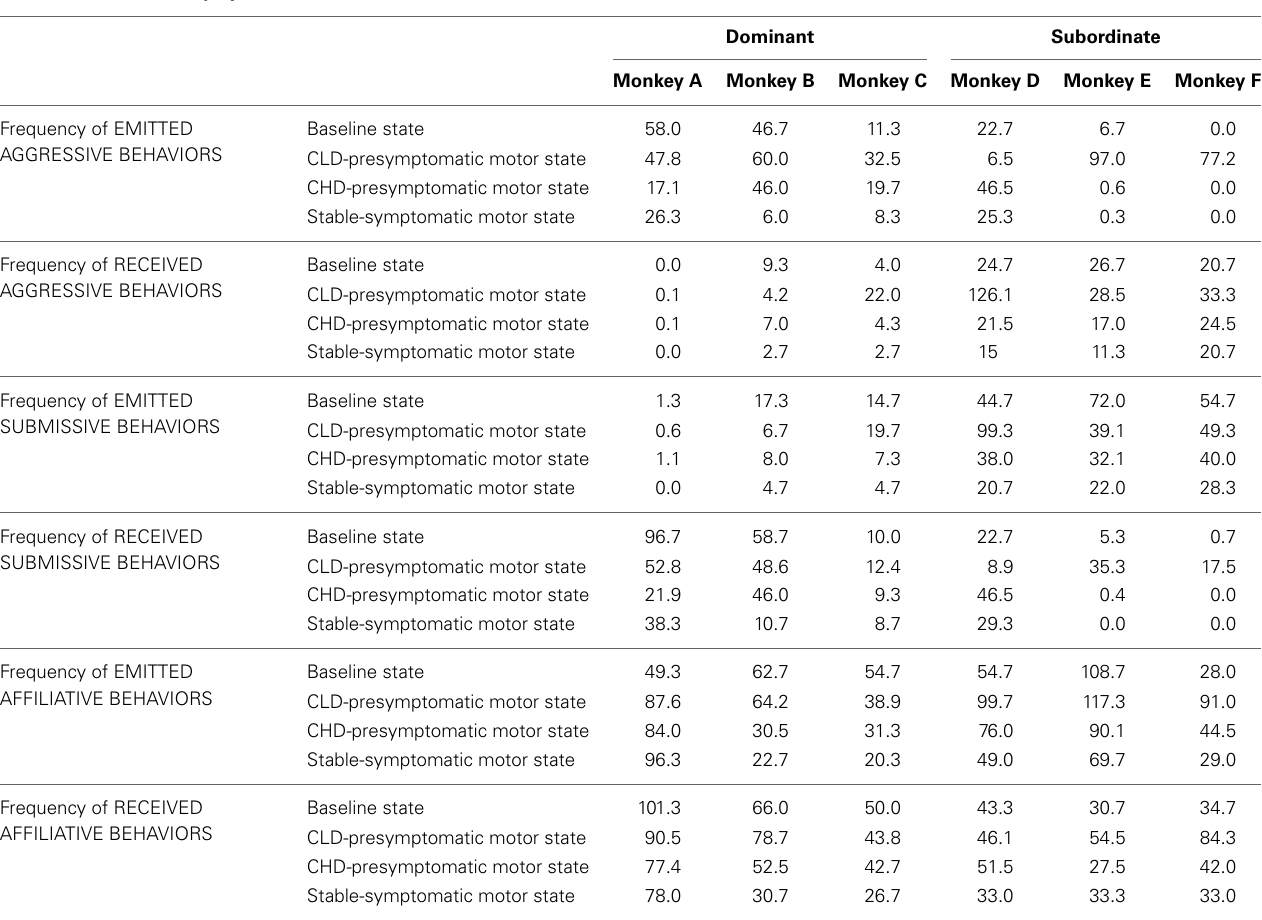
Table 2 | Individual frequency of the three categories of social behaviors during the baseline state, the CLD and CHD-presymptomatic motor states and the stable-symptomatic motor